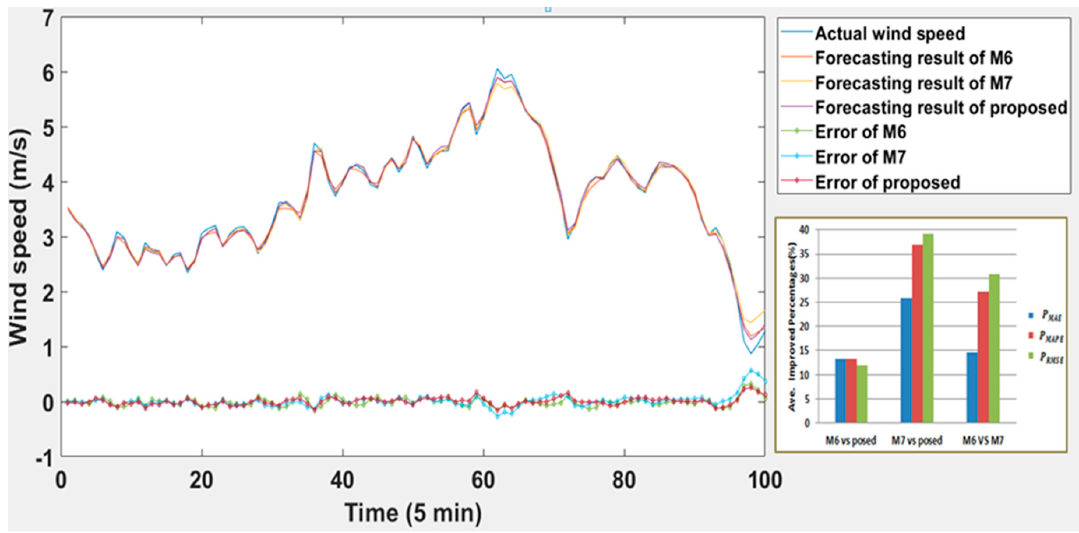
ff erent data processing Figure 11. Comparison of different data processing methods. Figure 11. Comparison of di Figure 11. Comparison of different data processing methods.